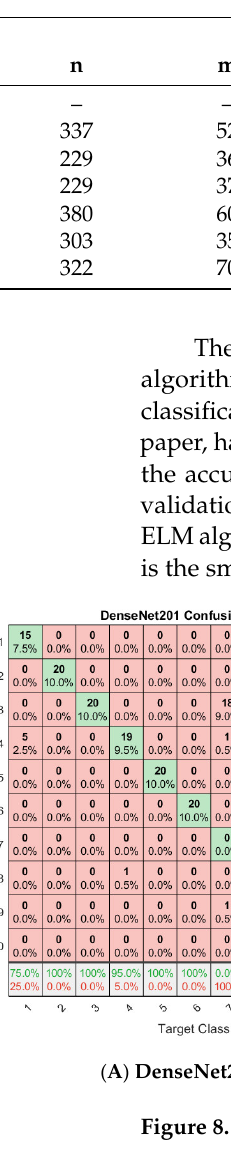
Table 8. Indicators of each algorithm